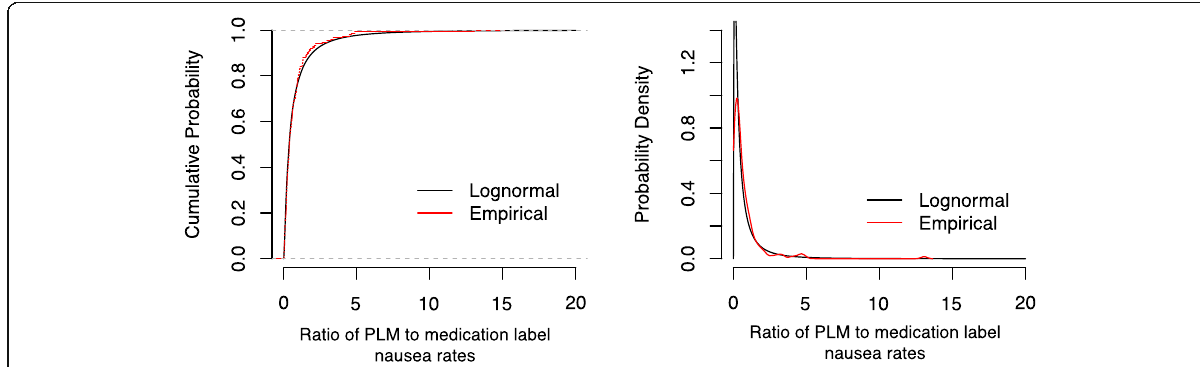
Fig. 5 Empirical and theoretical lognormal distributions of reporting ratio. Empirical distribution of the reporting ratio of PLM nausea rates to medication label nausea rates and a theoretical lognormal distribution with (natural log scale) mean − 1.01 and standard deviation 1.31. Distributions based on data from 150 treatments with non-zero medication label nausea